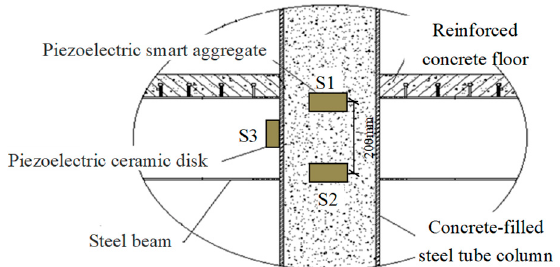
Figure 6. Layout of piezoceramic transducers installed in a joint.